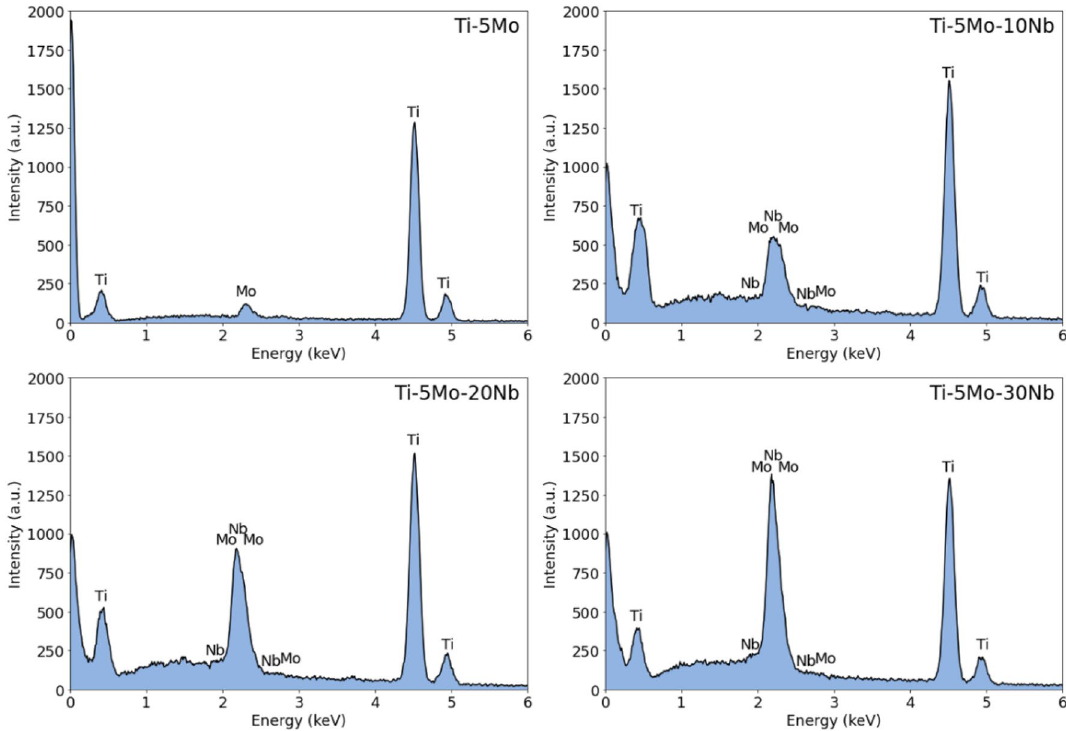
Figure 1. Qualitative chemical analysis of as-cast Ti-5Mo-Nb system alloys by